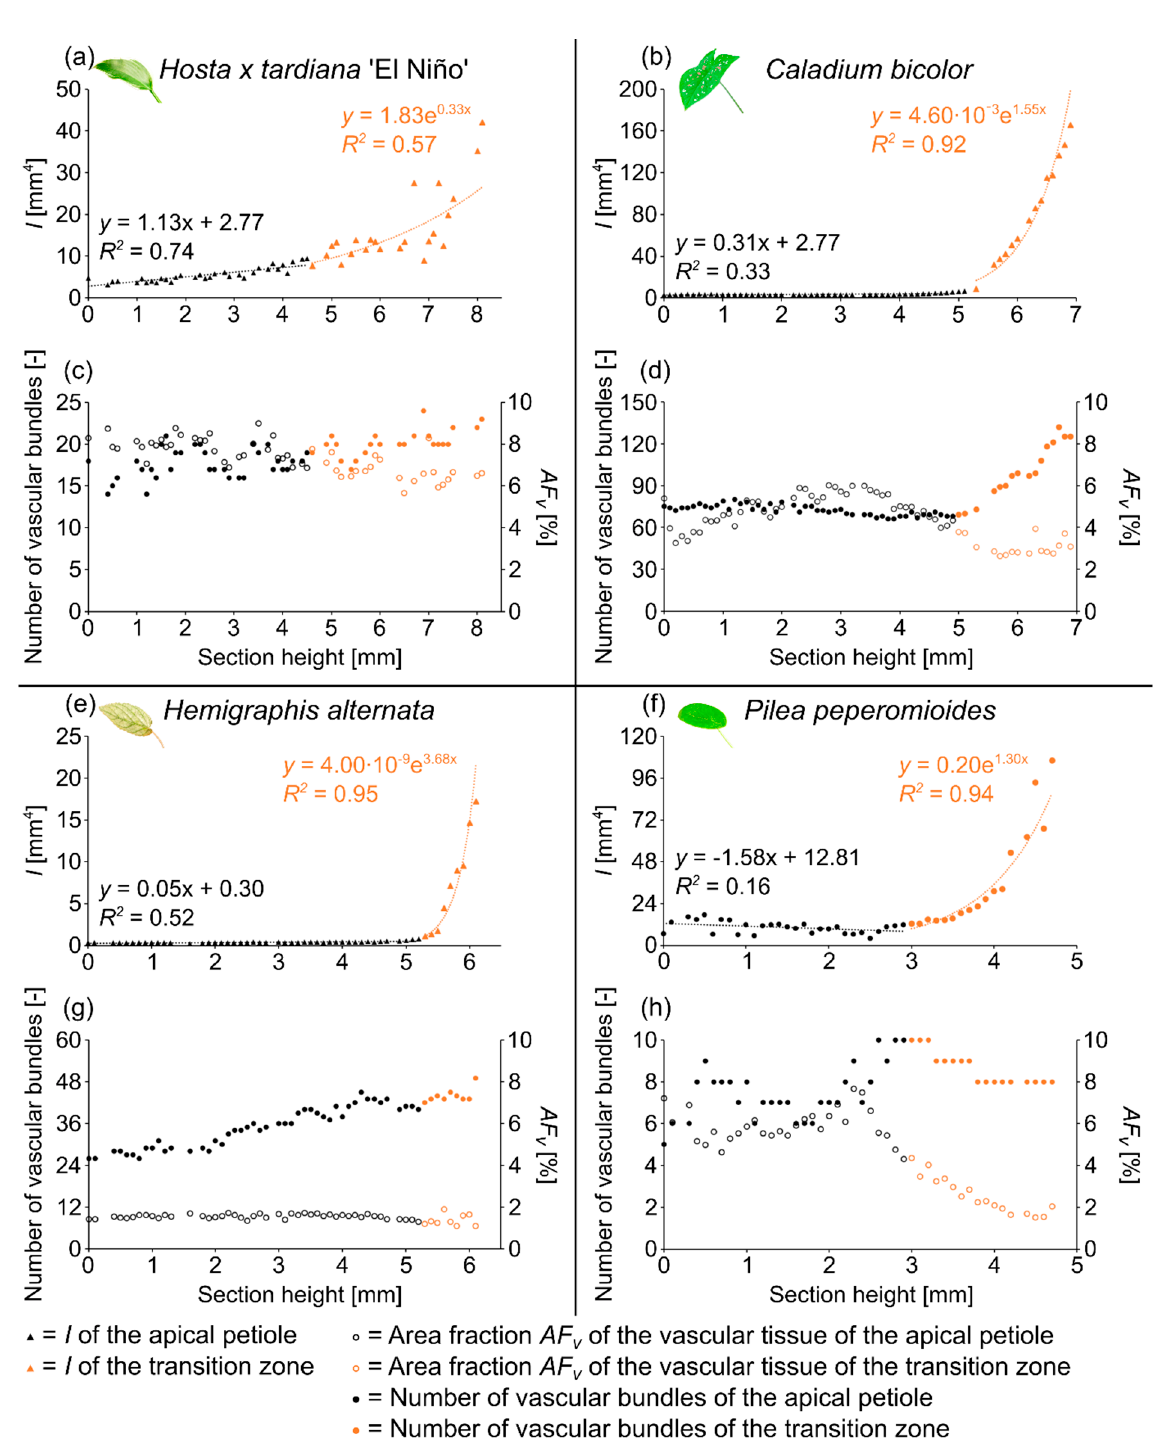
Figure 1. Axial second moment of area I ( a , b , e , f ), number of vascular bundles, and area fraction of the vascular tissue AF v ( c , d , g , h ) of the apical petiole and the transition zone of one leaf of Hosta x tardiana ‘El Niño’ ( a , c ), Caladium bicolor ( b , d ), Hemigraphis alternata ( e , g ), and Pilea peperomioides ( f , h ) plotted against the section height (0 = basal end of the samples).